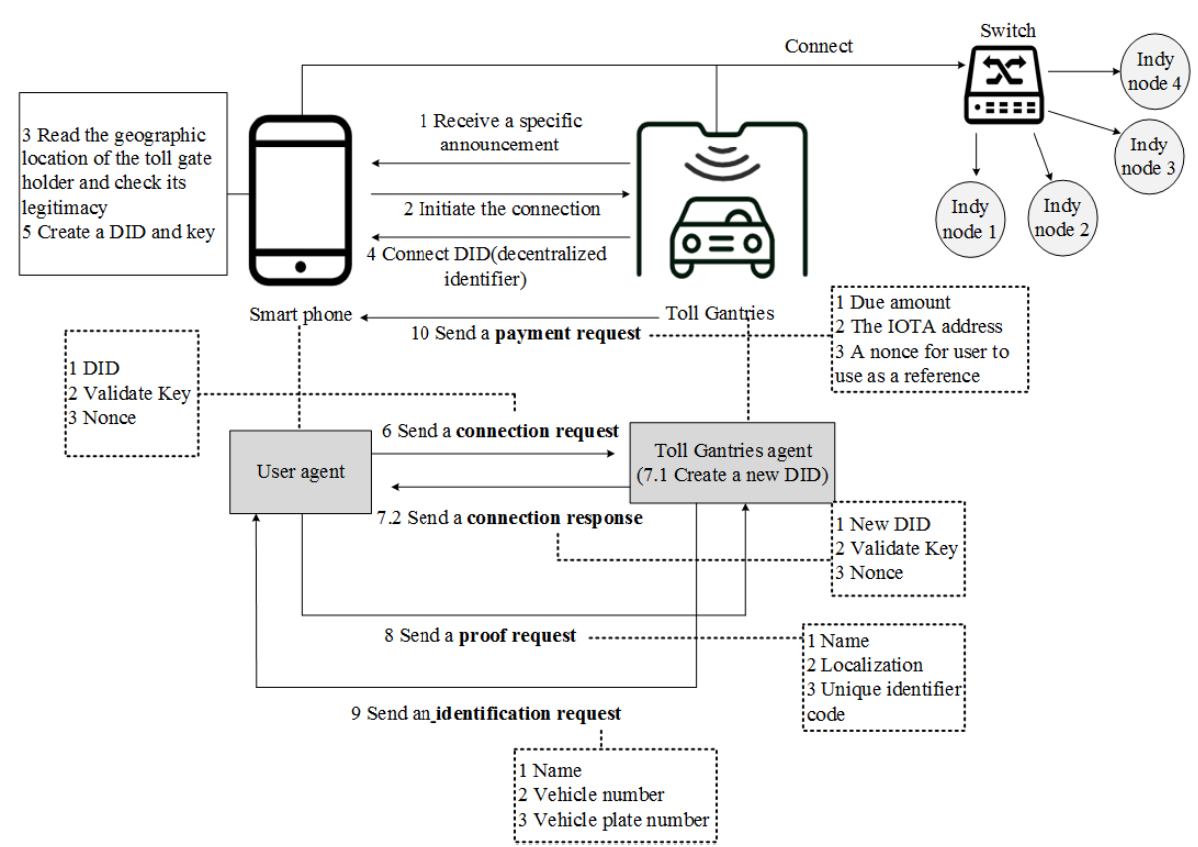
Figure 42. Reconstruction diagram of reference [74].